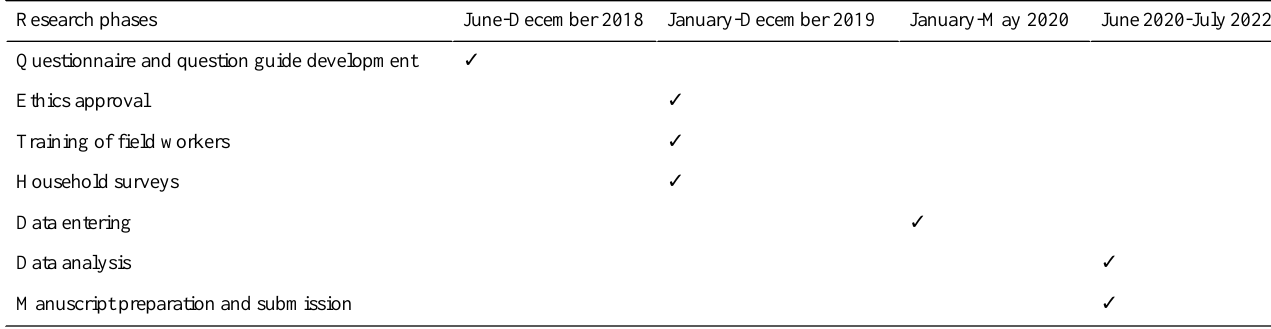
Table 1. Timeline of research